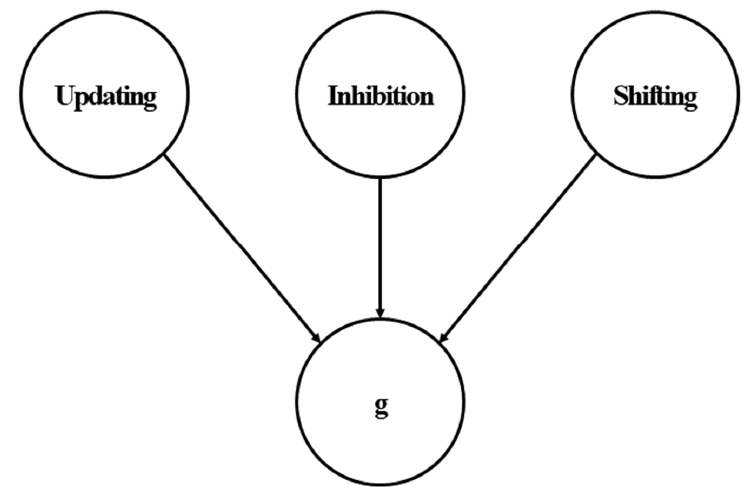
Figure 4. Conceptual model of the relationship between executive functions and g .